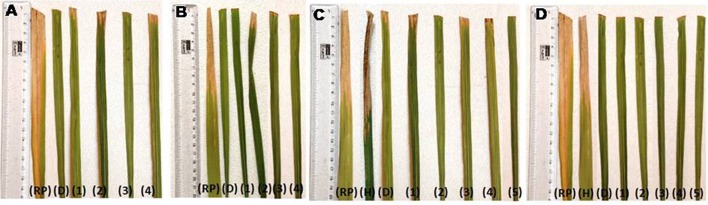
Phenotypic screening of the selected intercrossed and double intercrossed lines against rice blast disease. (A) Phenotypic screening of IC1F5 lines (Xa21 + Pi2 + Pi54) against rice BB resistance with DX-020 isolate. (B) Phenotypic screening of IC2F5 lines (Xa21 + Xa33 + Pi54) against rice BB resistance with DX-066 isolate. (C) Selected DICF3 lines against rice BB resistance with DX-020 isolate. (D) Selected DICF3 lines against rice BB resistance with DX-066 isolate. Along with (RP) Recurrent parent (RPHR-1005), (D) donor parents [RP Bio patho-1 for (A,C) and FBR1-15 for (B,D)], (1) to (6) were selected lines. Forty-five days old seedlings were inoculated by clip inoculation method (Kauffman et al., 1973). The selected lines have shown high level of resistance equal to the donor parents. The lesion length and disease score were calculated based on IRRI- SES (IRRI- standard evaluation system; IRRI, 1996).